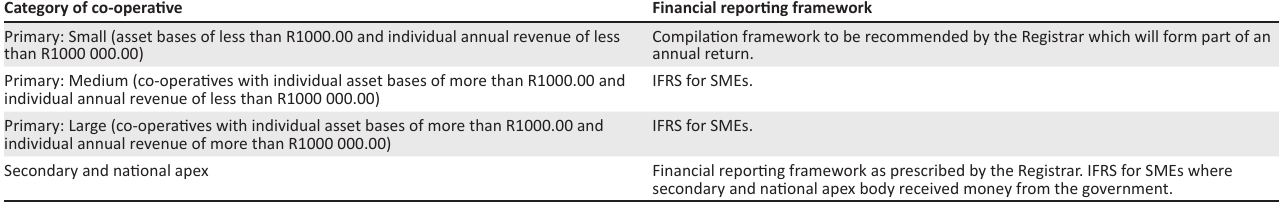
TABLE 1: Financial reporting framework by category of co-operative. Category of co-operative Financial reporting framework